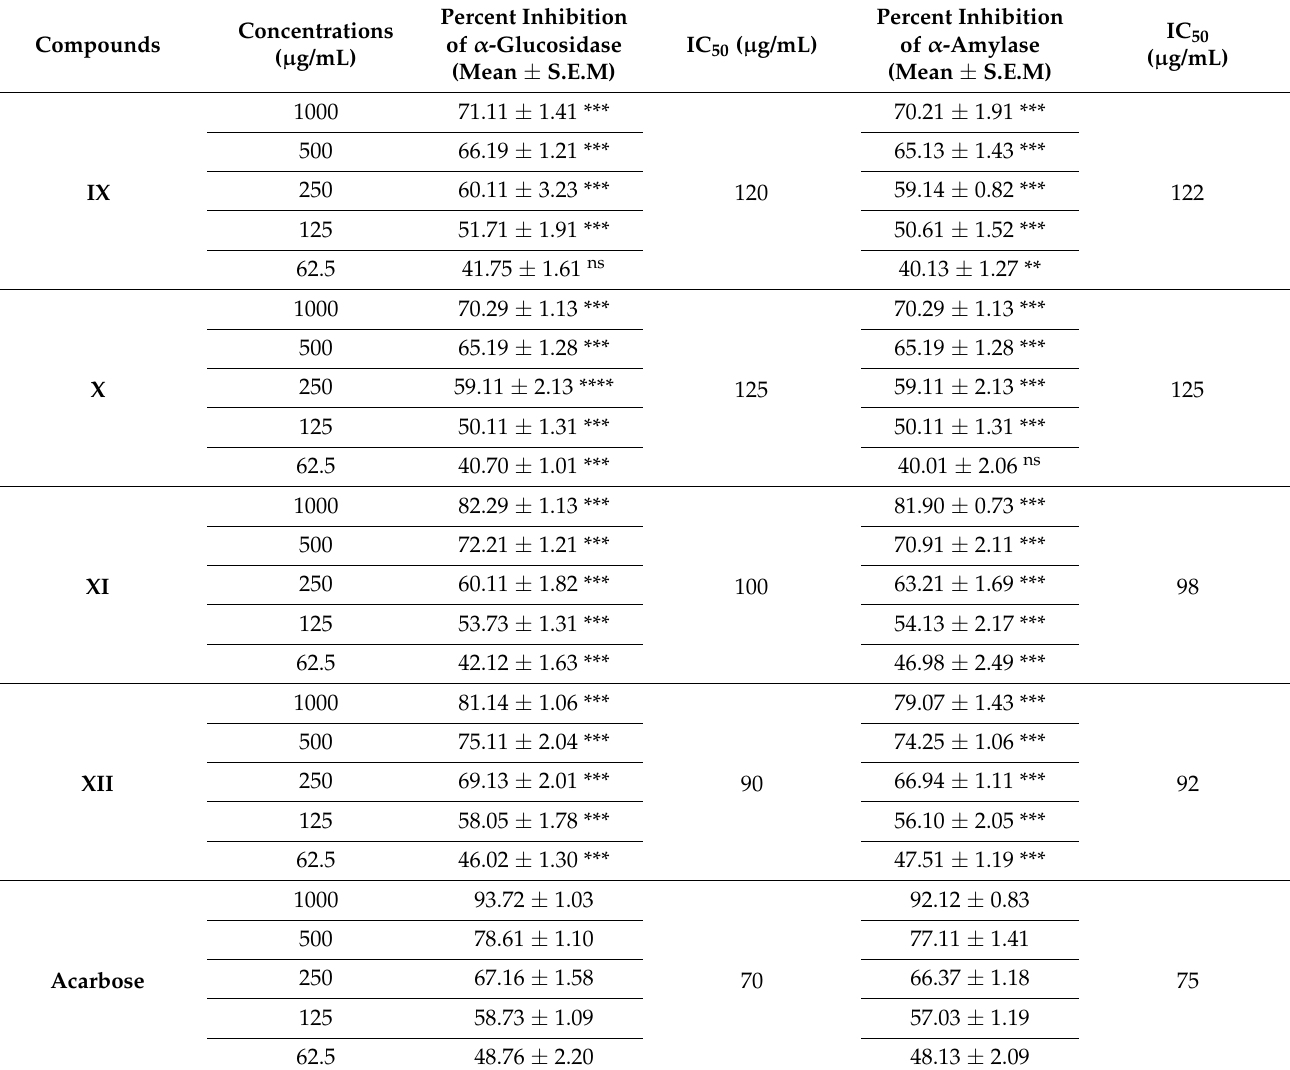
Table 3. α -glucosidase and α -amylase inhibition of the isolated